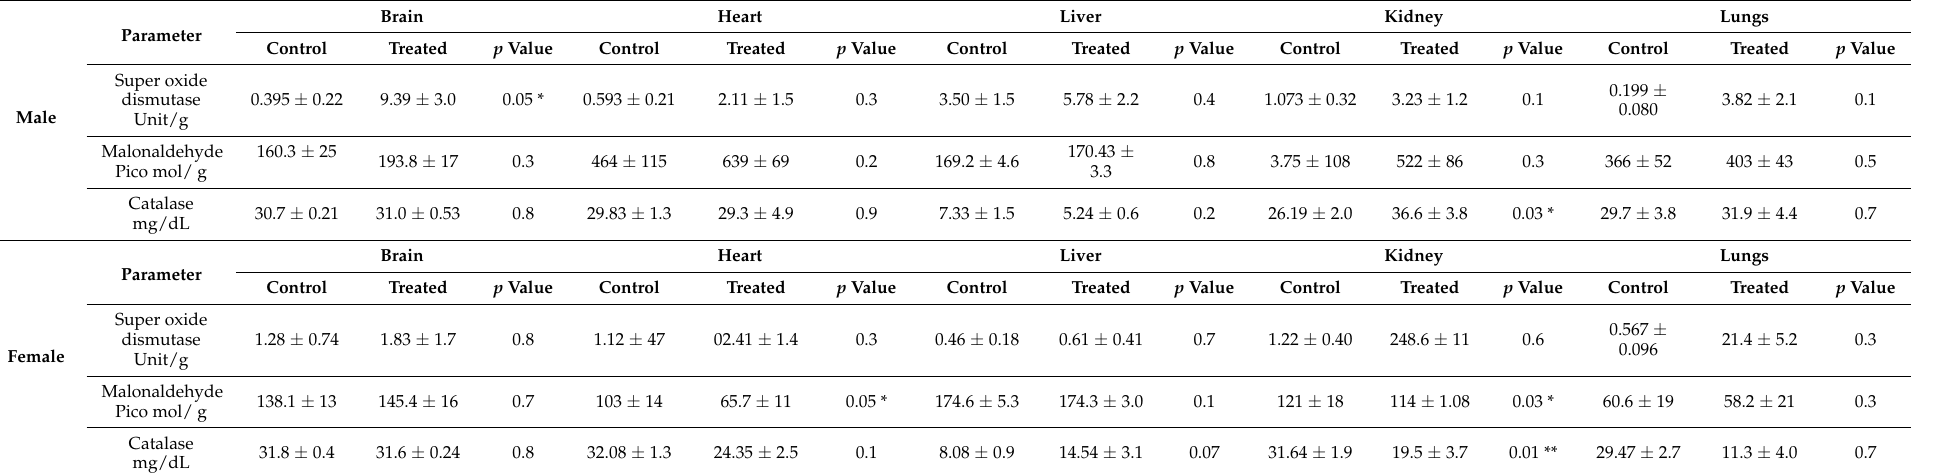
Table 4. Comparison of various studied antioxidant parameters between male/female albino mice supplemented orally for 11 days either with saline solution or present the results for the 2 sample t -test calculated for each